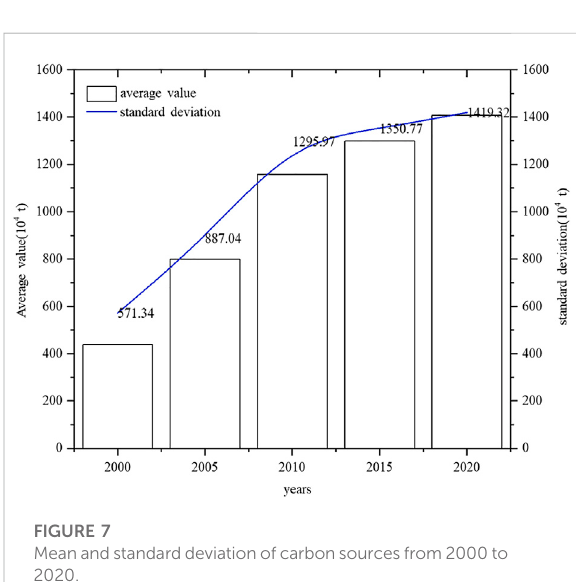
the carbon de fi cit range gradually spreads from north to south, and the high-value areas of the carbon de fi cit are mainly concentrated between 31 ° N and 39 ° N.